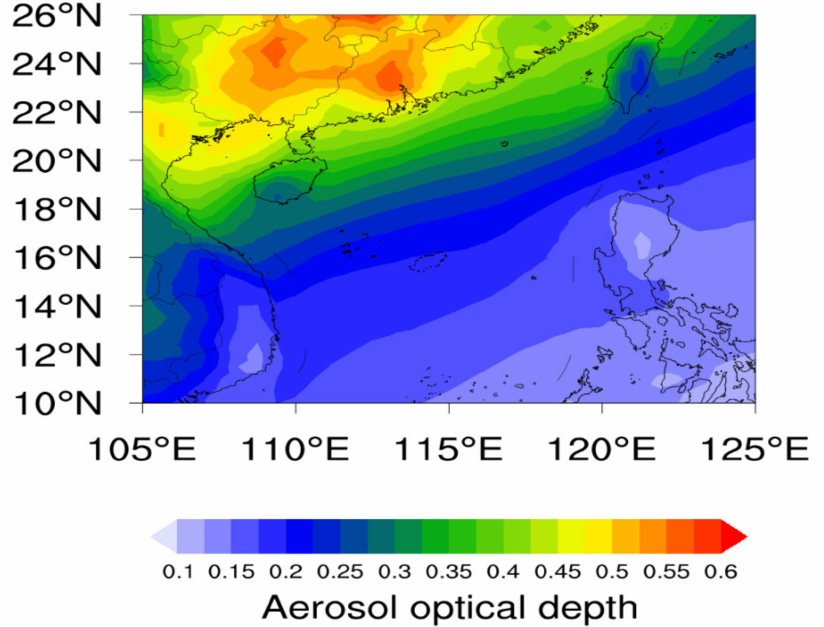
Figure 12. The spatial distribution of the annual average AOD at 550 nm over the study region using the long-term MERRA-2 atmospheric products from 2012 to